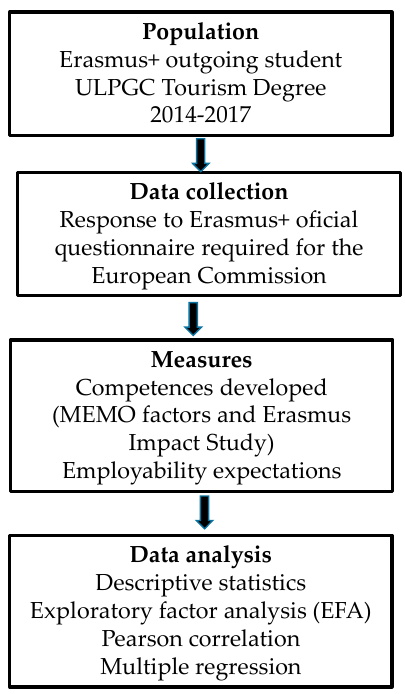
Figure 1. Data gathering and treatment.